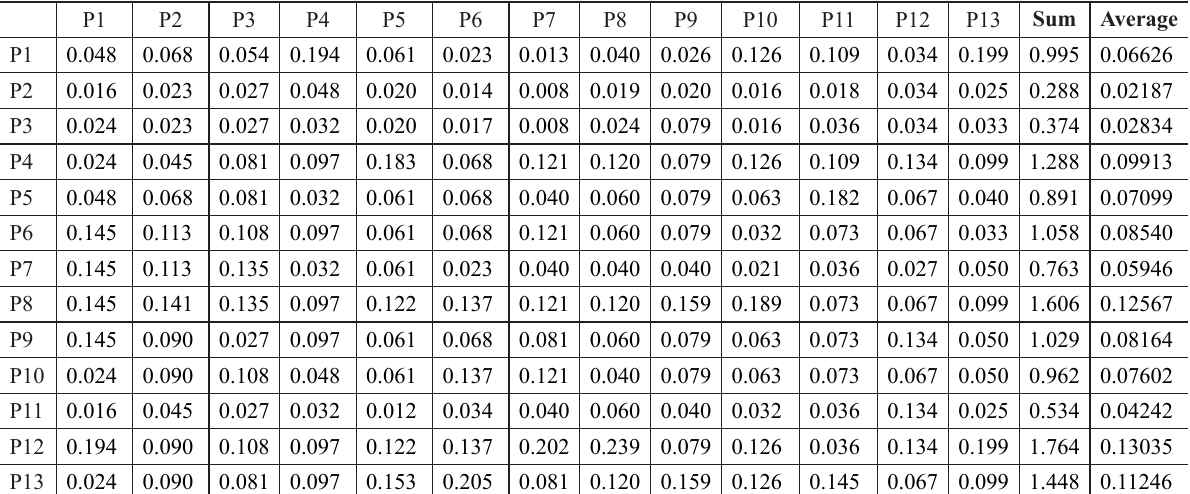
Table 2. Normalised matrix of the problem pair comparison with AHP method